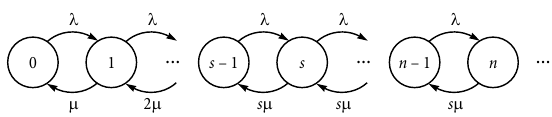
Fig. 4. The flow diagram for